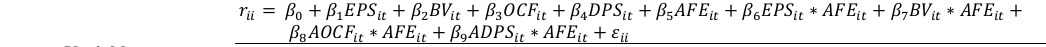
Results of Regression Analysis Related to Model